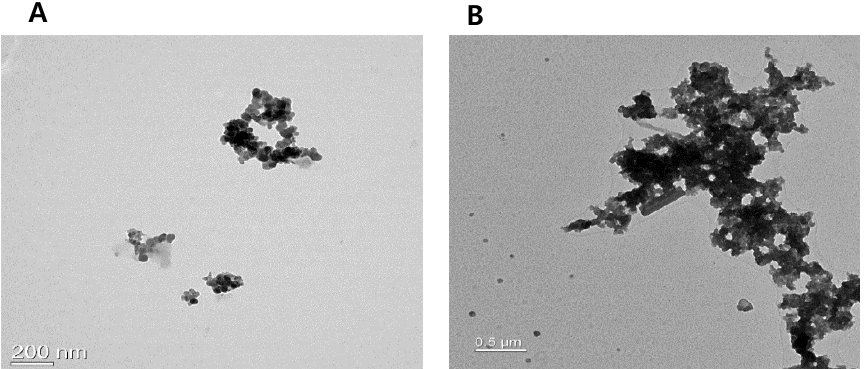
Figure 1. Transmission electron microscopy images of PM2.5 ( A ) and TSP ( B ). Length of bar at lower left section in each photo: ( A ) 200 nm and ( B ) 0.5 µm.